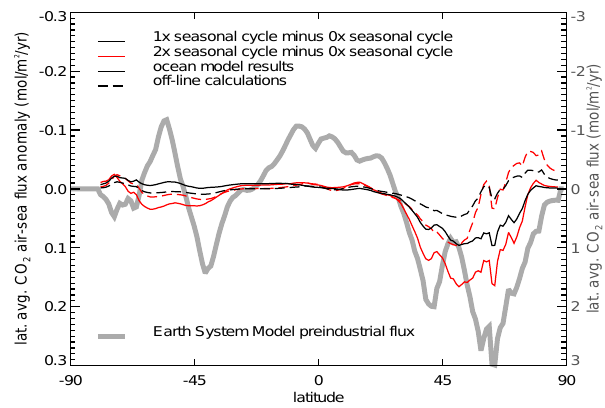
Fig. 3. Latitudinally averaged impact of changing atmospheric CO 2 seasonal cycle amplitude on the air-sea flux of CO 2 calculated as averages over the first perturbed year of ocean-model simulations (solid black and red lines), and instantaneously after the CO atm per- 2 turbation using off-line calculations (dashed black and red lines). CO 2 air-sea flux difference calculated between the model’s pre- industrial atmospheric CO 2 seasonal cycle and a situation with no seasonal cycle (black), and between two times the model’s pre- industrial atmospheric CO 2 seasonal cycle and a situation with no seasonal cycle (red). Positive values represent a relative flux into the ocean. It can be seen that by increasing the seasonal cycle magni- tude (but keeping the annually averaged value at individual points, and therefore globally, constant), the ocean takes up additional CO 2 in the mid-to-high latitudes, and takes up less CO 2 in the high lati- tudes. The enhanced relative CO 2 in- and out-gassing occurring in the mid and high Northern Hemisphere is a response to the larger seasonal cycle of atmospheric CO 2 in this hemisphere, and a tighter coupling between wind-speed, ocean CO 2 solubility, sea-ice change and atmosphere CO 2 concentration seasonality (see Figs. 8, 9 and 7 and accompanying text), relative to that in the low latitudes and Southern Hemisphere. The model-simulated latitudinally averaged pre-industrial air-sea flux of CO 2 is plotted in the dotted gray line for reference. Note the order of magnitude of increase in scale when considering the absolute air-sea flux, compared to that used for changes in